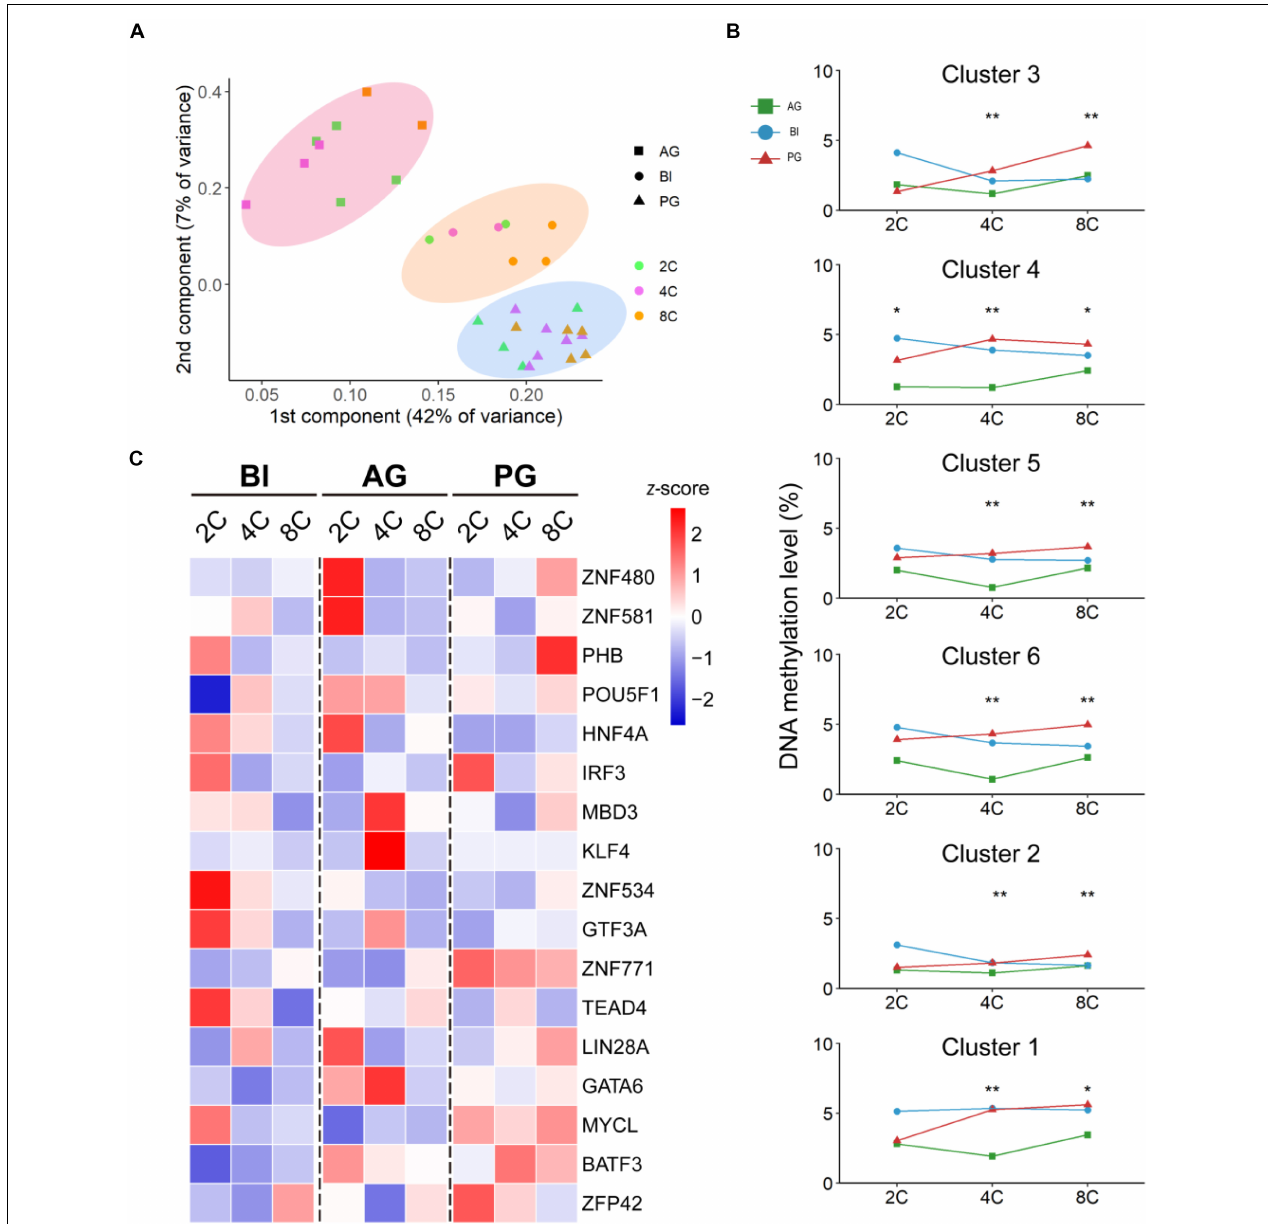
FIGURE 6 | The promoter CPG-methylation state in biparental and uniparental cells. (A) PCA of promoter methylation of all detected TFs. (B) Mean promoter methylation tendency of each development module, corresponding to clusters in BI embryos. * p < 0.05, ** p < 0.01 (Kruskal–Wallis test). (C) Promoter methylation (mean ± SE) of 17 hub